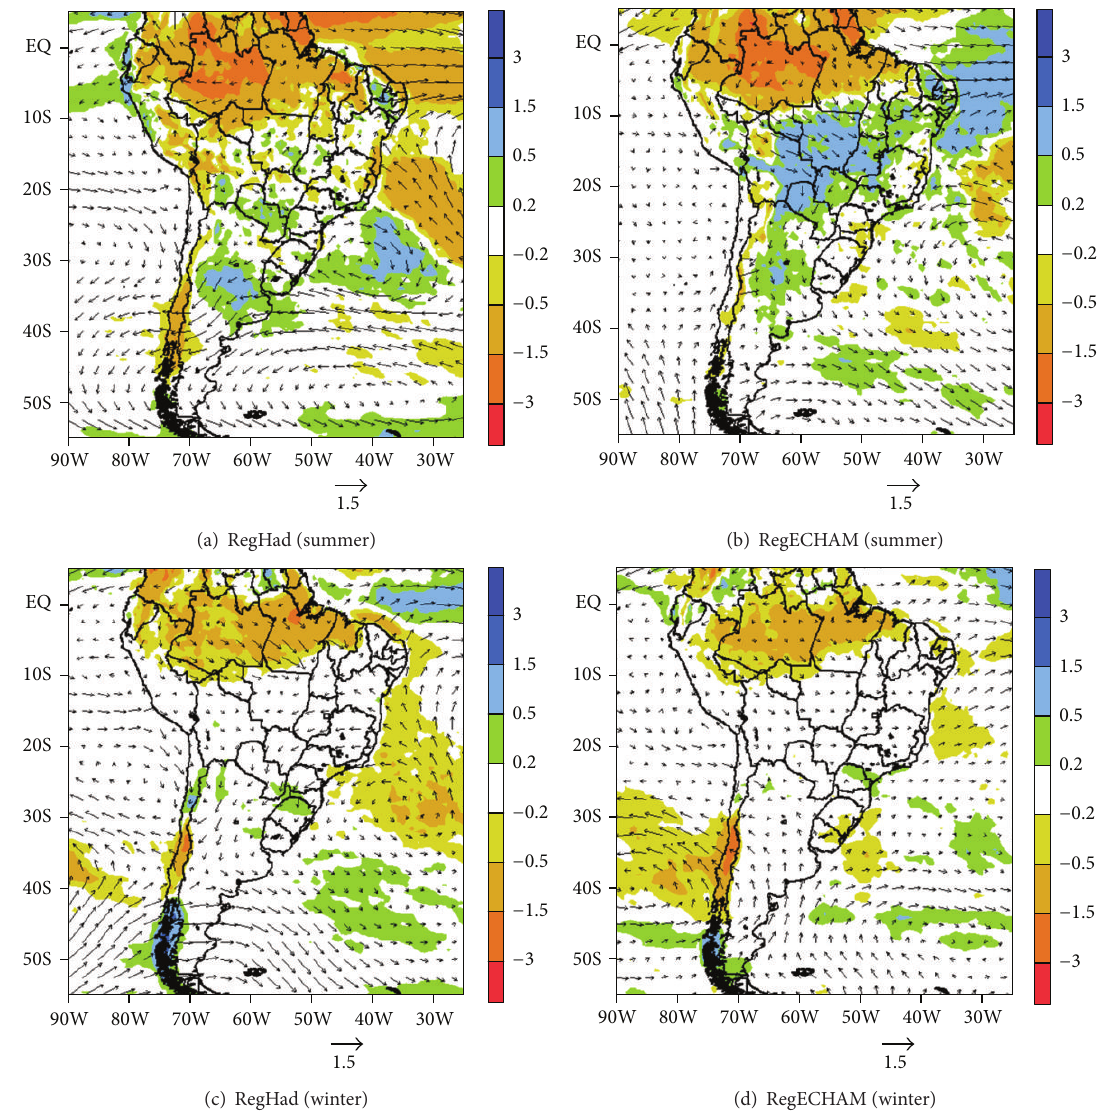
Figure 6: Projected mean change in the near-future climate (2010–2040 minus 1961–1990) of precipitation (mm day −1 ) and 850 hPa wind (ms −1 ; arrows) simulated by RegHad (left column) and RegECHAM (right column) for summer (top) and winter